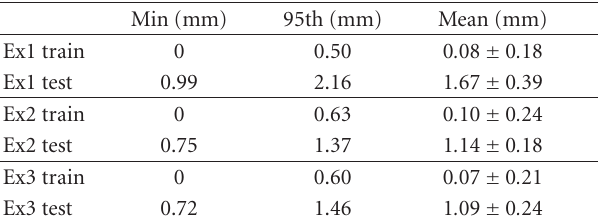
Table 9: Hausdor ff distance for in vivo experiment with LV.